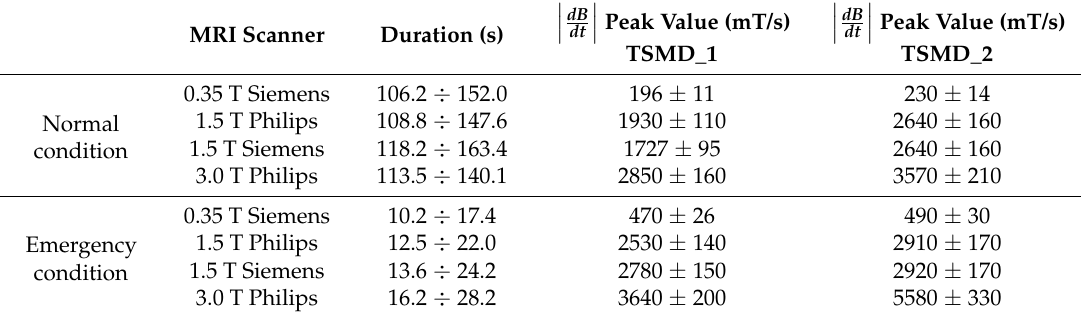
Table 2. Measurements conducted in different MRI sites using the TSMDs positioned on the MRI technicians’ Head during routine patient positioning (Normal) and when simulating an emergency